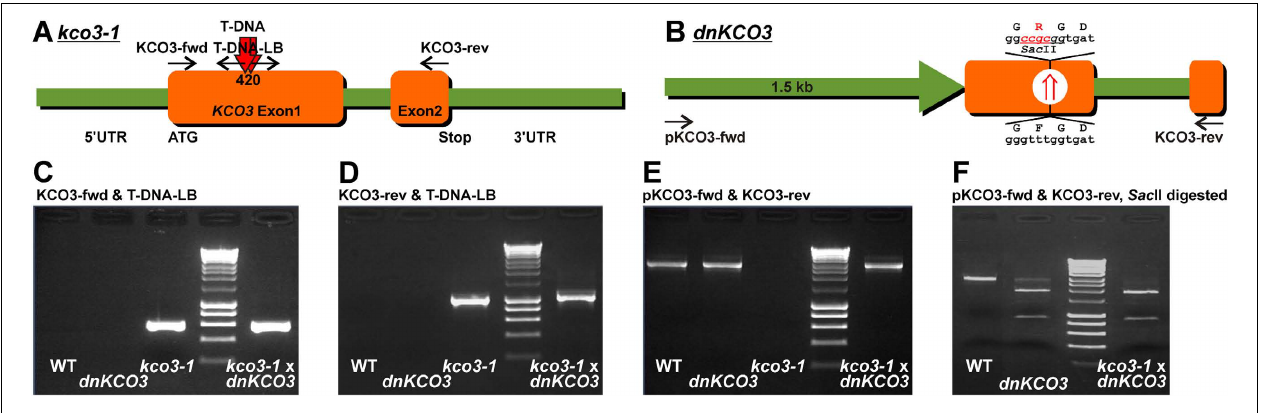
dnKCO3 does not show any amplification product with theT-DNA primer sets. (E) PCR was performed with the indicated gene specific primer pair. Amplification can be observed in Col-0 wild-type, dnKCO3 and kco3-1 × dnKCO3 . No amplification product is detectable in the homozygous T-DNA insertion line ( kco3-1 ). (F) Sac II restriction digestion of the PCR products obtained by amplification with the gene specific primer pair. PCR product from Col-0 wild-type was not digested.The amplification product from the dnKCO3 mutant was digested but some undigested product can also be seen.The PCR product from kco3-1 × dnKCO3 shows complete